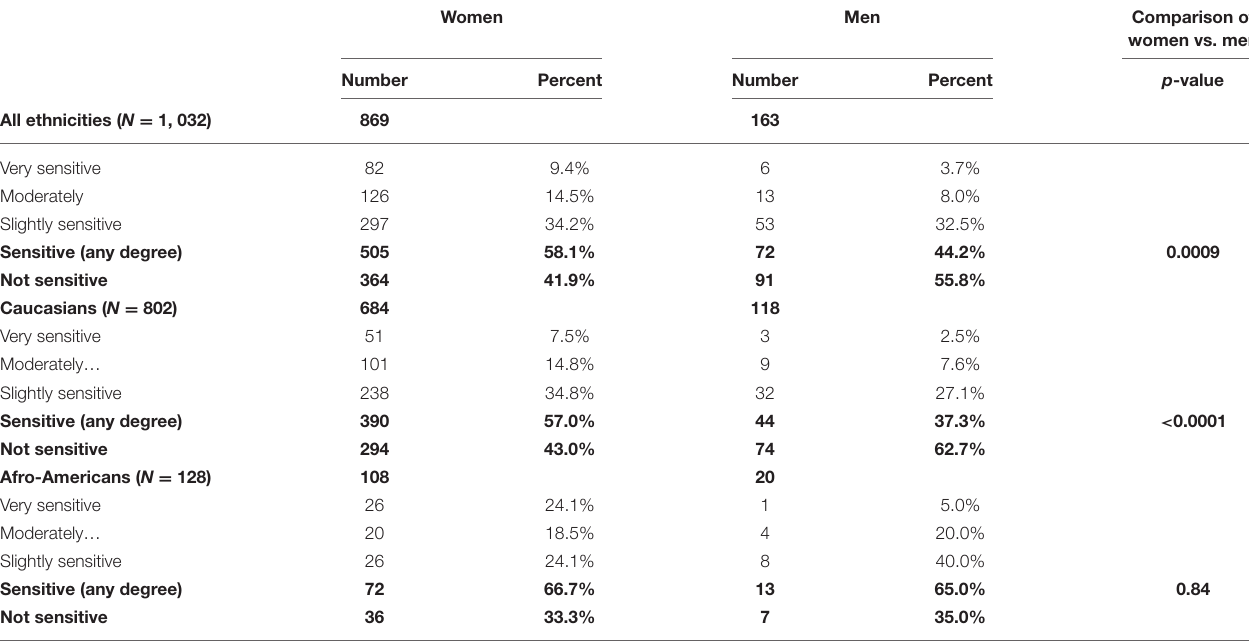
TABLE 1 | Perceptions of self-declared sensitive genital skin by gender and ethnicity. Women Men Comparison of